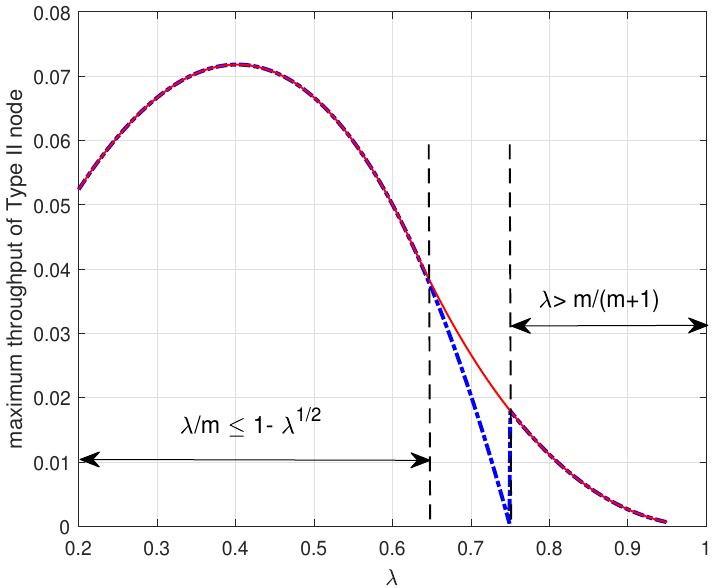
Figure 6. Maximum throughput T ∗ of the Type II node attained by controlling the transmission II probability µ 2 depending on the packet arrival probability λ when m = 3. The red solid line in the figure denotes the maximum throughput of the Type II node given by the Corollary